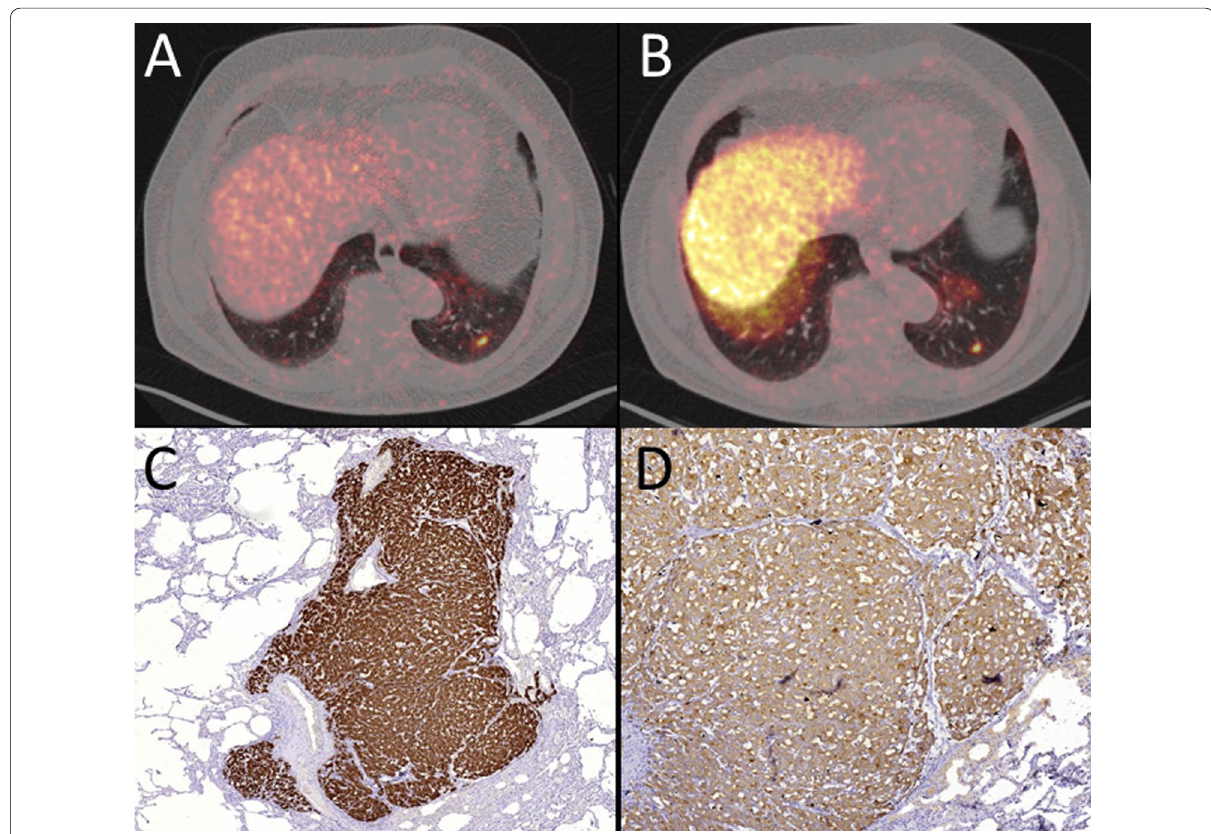
Fig. 7 Axial fused [ 68 Ga]-Ga-PSMA-11 PET/CT ( A ) and [ 18 F]-F-PSMA-1007 ( B ) with concordantly intense focal uptake in a pulmonary metastasis in the left lower pulmonary lobe. Immunhistochemial confirmation of PSMA- ( C ) and PSA- ( D ) expression of the pulmonary metastasis ( D )